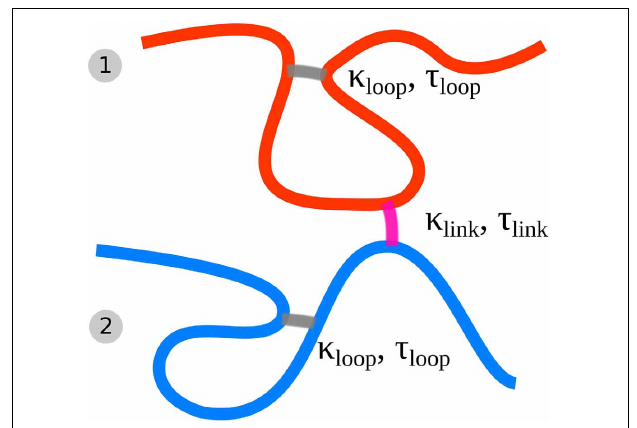
FIGURE 1 | Schematic of the Dynamic Loop Model for mitotic sister chromatids. Each chain represents a coarse grained sister chromatid (fiber 1 and 2). The folding of each single chromatid is modeled by internal cross-linking of each of the chromatids forming chromatin loops (gray cross-links). Furthermore the model sister chromatids can be tethered to each other by inter-chromatid cross-links (purple cross-links). We model both kind of cross-links with a dynamic